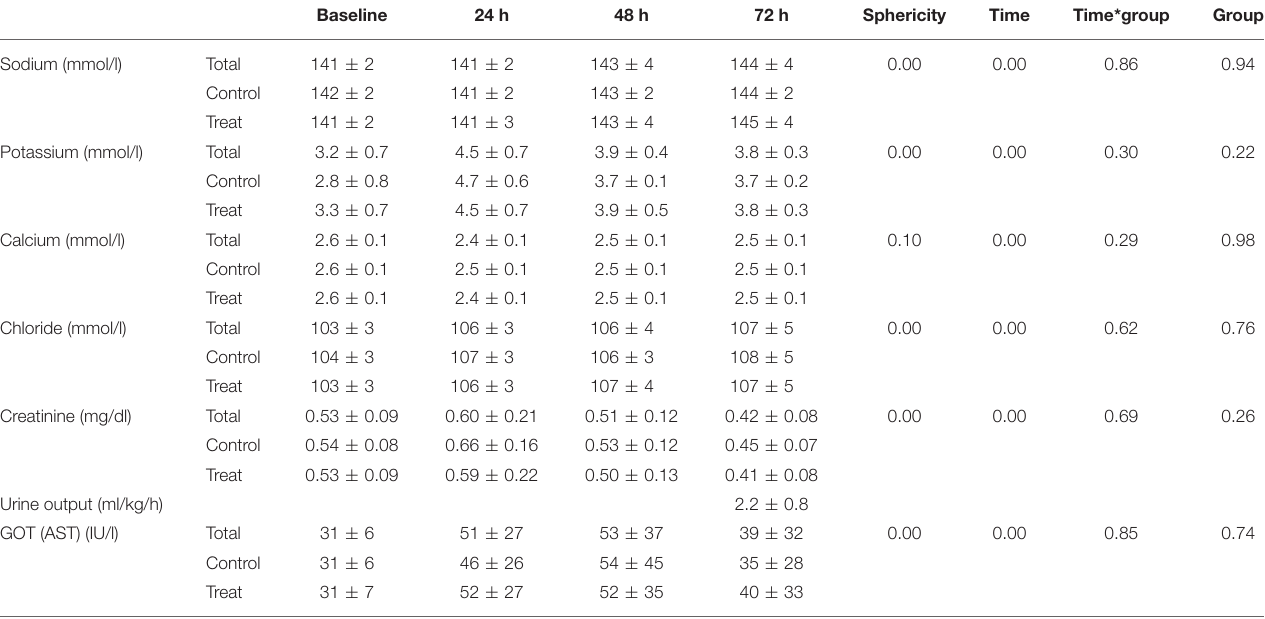
TABLE 2 | Electrolytes, renal function, and GOT. Baseline 24 h